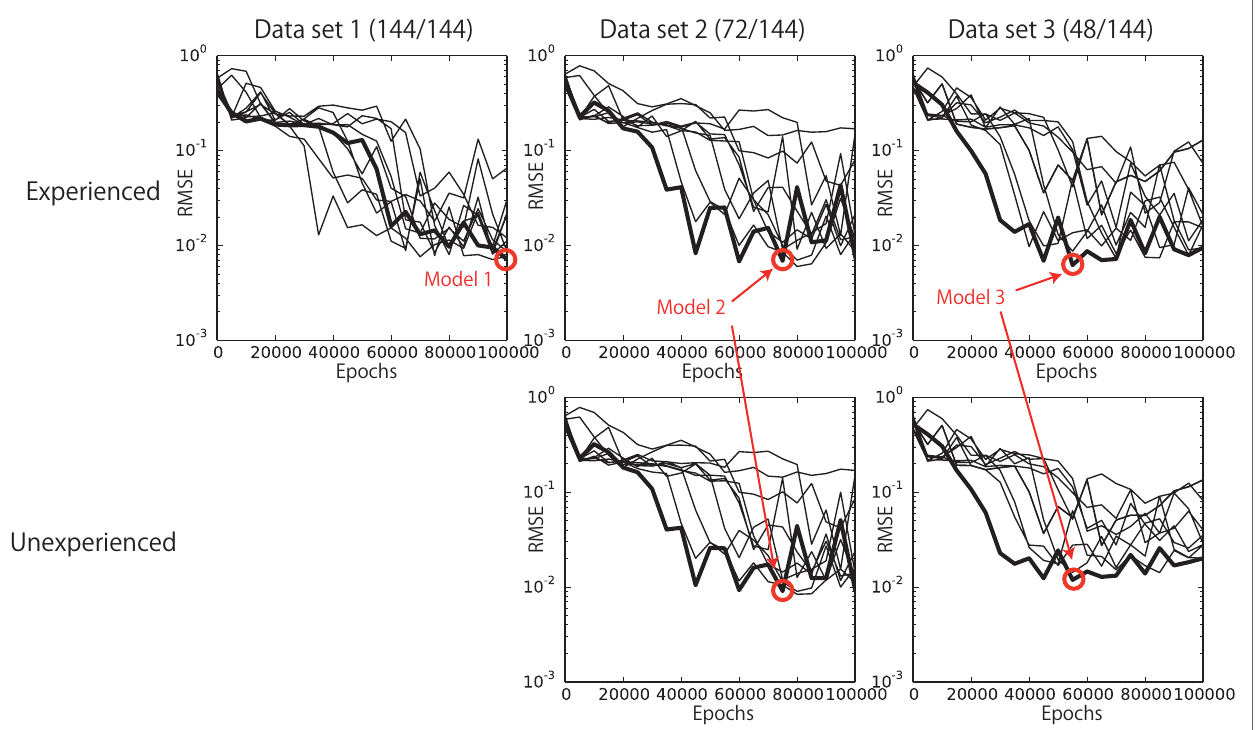
FIGURE 5 | The learning progress with respect to each dataset . Each line corresponds to a learning process determined by one random seed. The red circles indicate the networks that scored the best performance among all the used random seeds and learning epochs. We call them Model 1, Model 2, and Model 3.